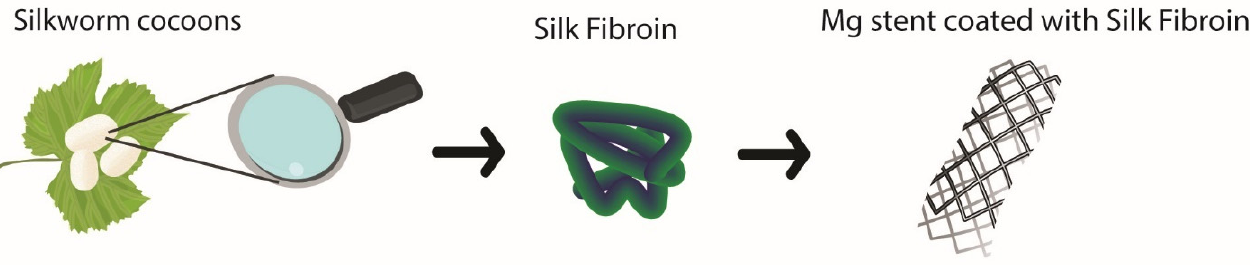
Figure 3. SF coated on Mg stent.